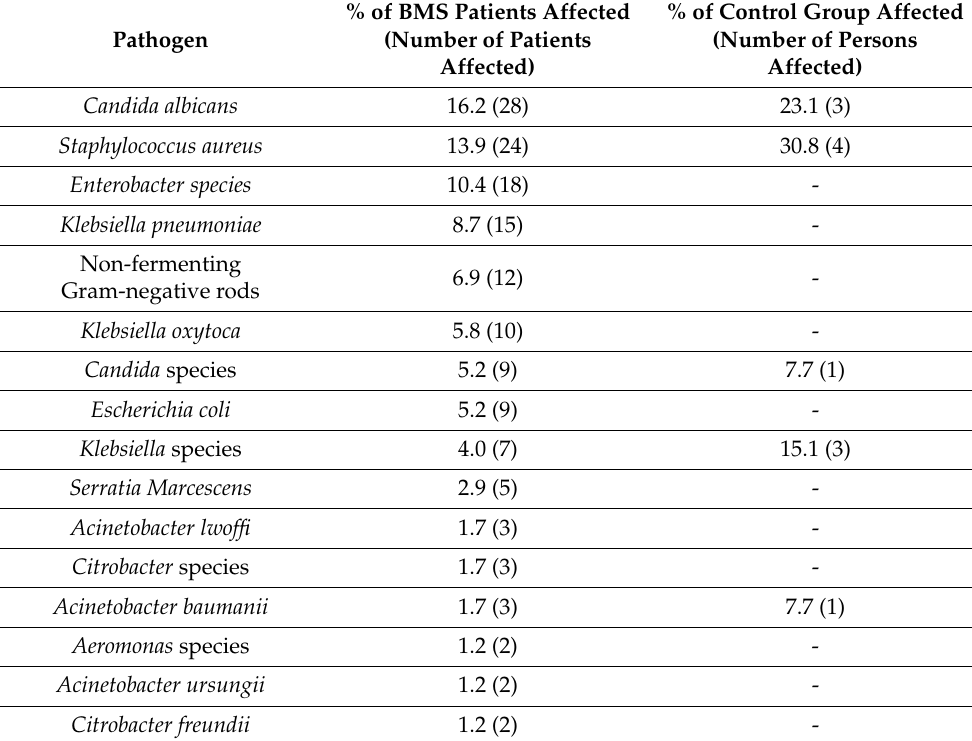
Table 1. BMS patients and control group individuals affected by